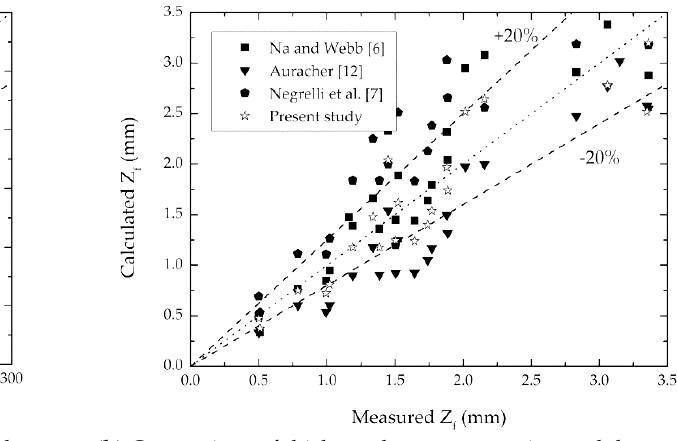
( a ) Comparison of density between experimental data and nu- ( b ) Comparison of thickness between experimental data and merical results numerical results Figure 8. Comparison between experimental data and numerical results with correlations at 60 min.